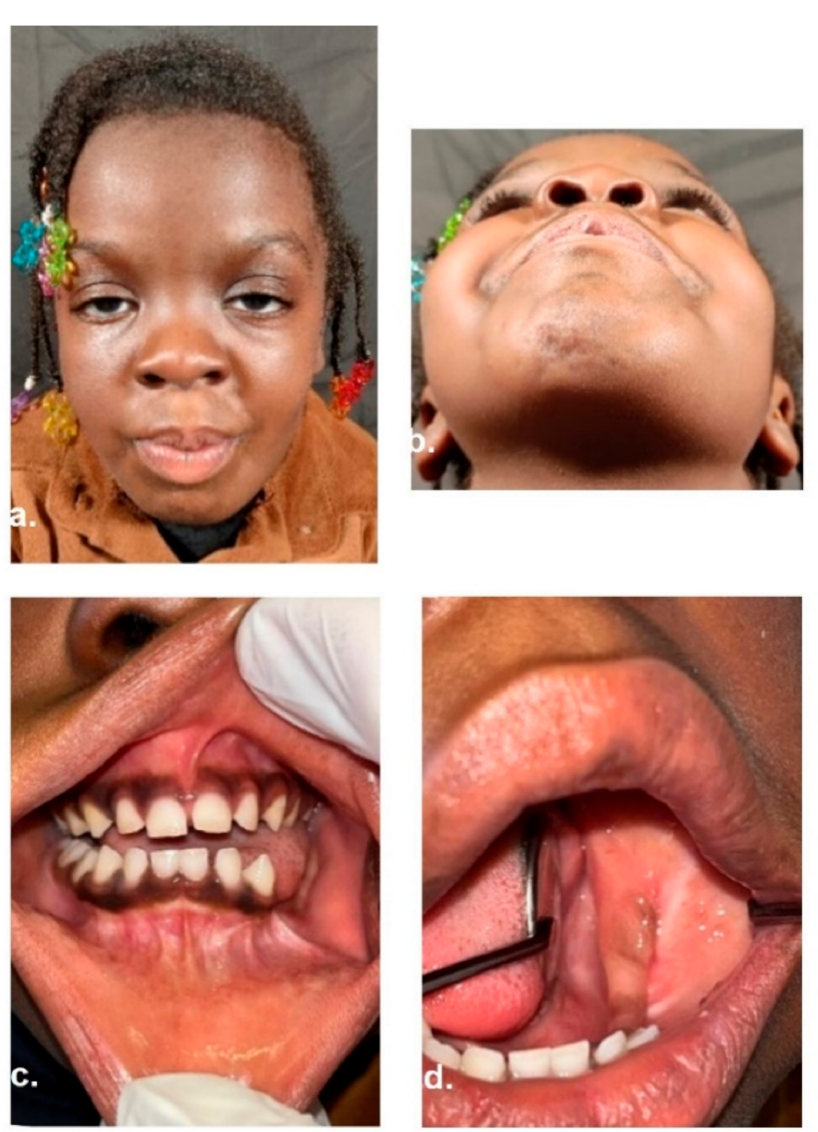
Figure 10. 22-month postoperative clinical condition. ( a ) Frontal view; ( b ) bottom-to-top view; ( c ) patient’s occlusion; ( d ) intraoral